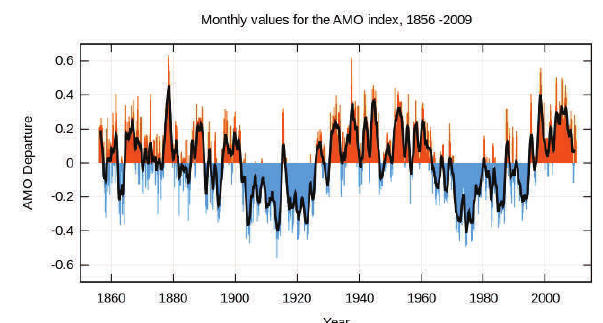
Figure 1. Monthly values of the Atlantic Multi-decadal Oscillation index, 1856-2009 (from Wikipedia, 2013). The index has a very clear quasi-60 year